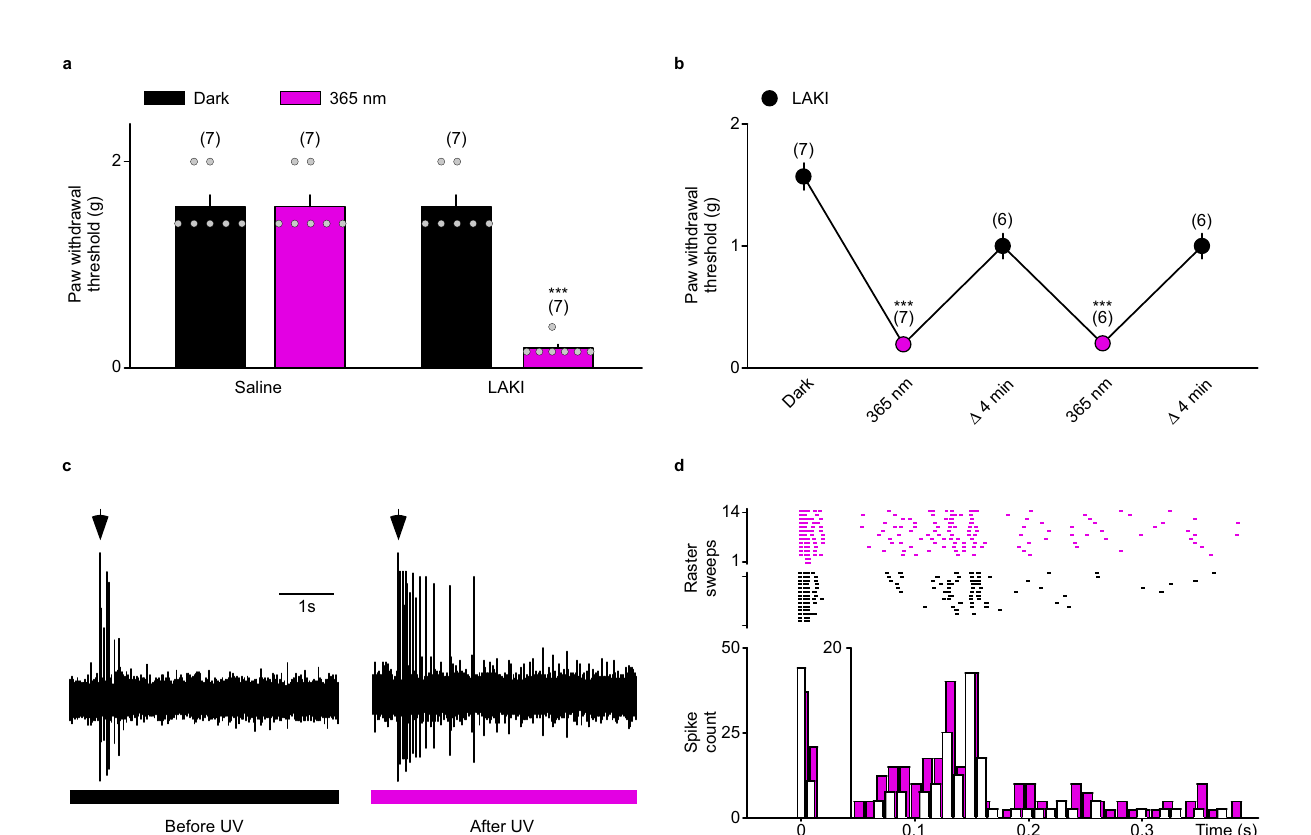
Fig. 3 | LAKI controls pain behavior in freely moving mice. a Representation of the experimental procedures (created with BioRender.com). b Schematic of experimental behavioral assays. Black arrows represent the injection or topical application of saline solution or LAKI. Magenta arrows represent the pulse of light at 365nm. Green arrows represent the measurement of nocifensive behavior or thermal and mechanical sensitivity. The red arrow represents extracellular in vivo recording. c Bargraphsummarizingtheaverageofnocifensivebehaviorelicitedby mice after ocular application of either saline or LAKI (100 µ M, 5 µ L) solution pre- ceded ornotbya20sillumination pulse(<1mW/mm 2 )at 365nm(magenta). n was obtained from three independent experiments. Statistical signi fi cance was deter- mined by Poisson GLM followed by Bonferroni ’ s post-test (*** p <0.001). d Bar graph showing the average of nocifensive behavior, making the distinction between scratching and wiping behavior, elicited by mice after topical application of either saline or LAKI (100 µ M, 5 µ L) solution preceded or not by a 20s illumi- nation at 365nm (magenta). n was obtained from three independent experiments. Statistical signi fi cance was determined by Poisson GLM followed by Bonferroni ’ s post-test (** p =0.00564 for scratching, ** p =0.0035 for wiping). e Bar graph sum- marizingtheaverageofthethermalpawwithdrawallatencyofmiceinjectedeither